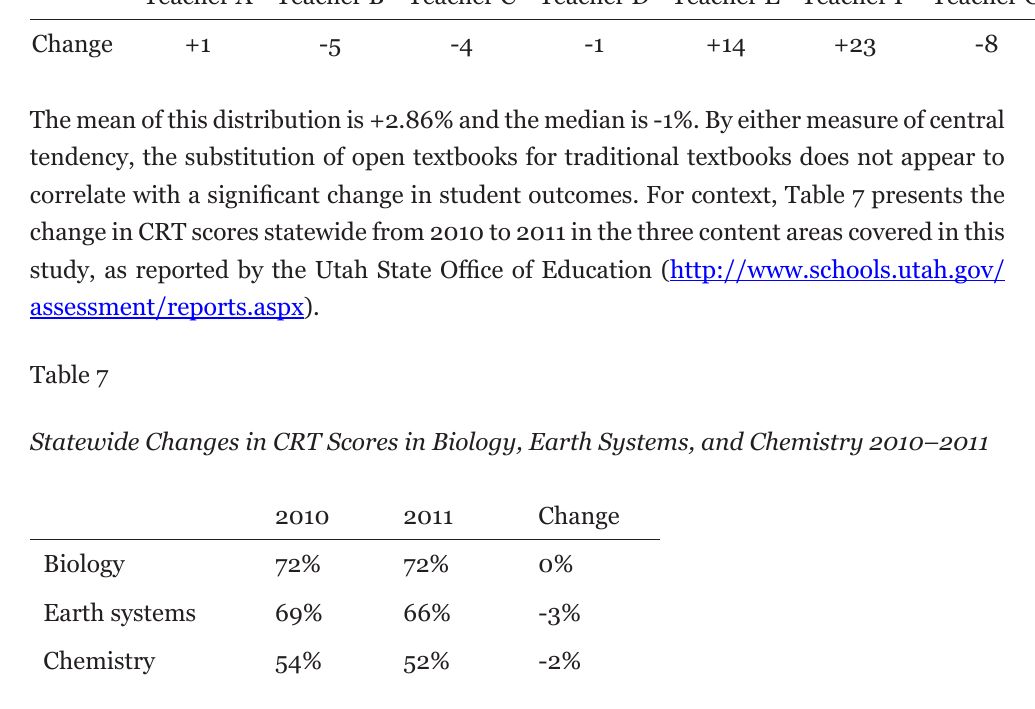
central tendency of this small data set. Table 6 shows the change scores.